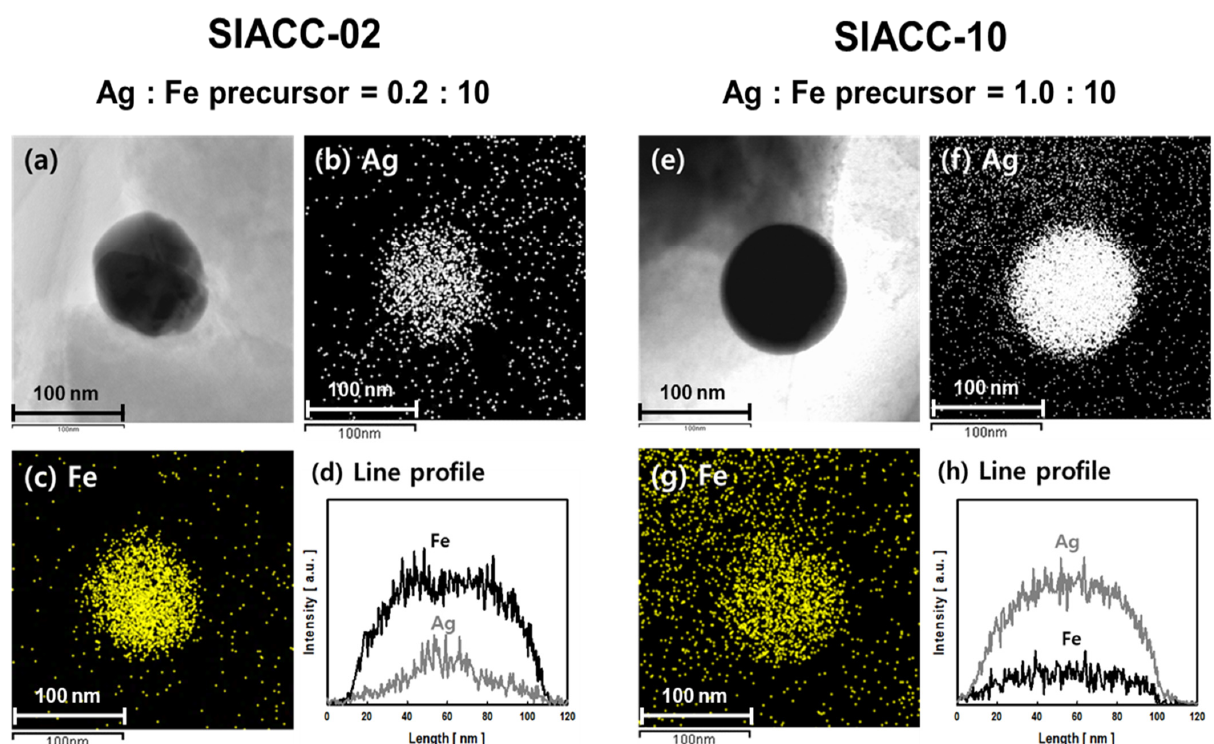
Figure 7. Real images ( a , e ), Ag element mapping images ( b , f ), Fe element mapping images ( c , g ), and line scanning profiles ( d , h ) of bimetallic nanoparticles (SIACC-02 ( a – d ) and SIACC-10 ( e – h )) observed by FE-TEM.